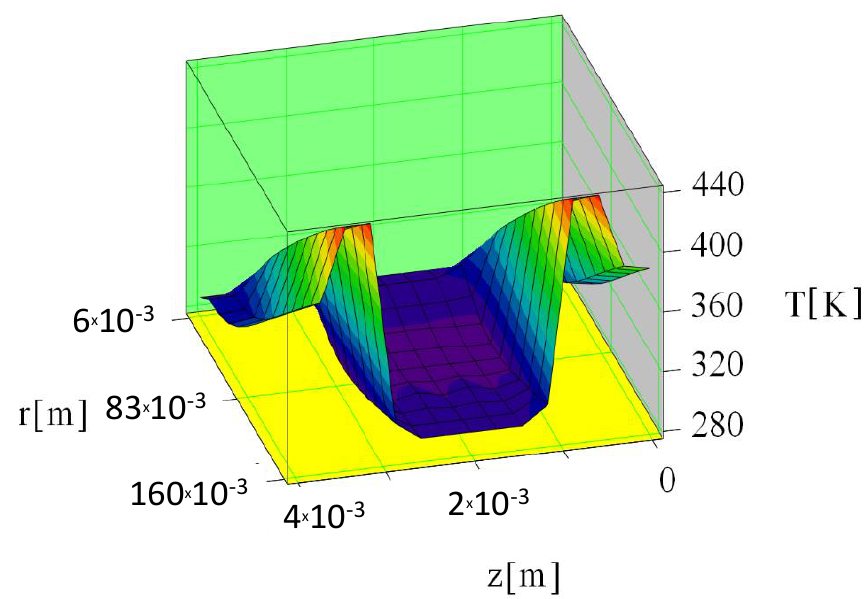
Figure 8. Graph of the temperature distribution within the disk gap with parameters corresponding to Figure 2 ( h = 4 × 10 –3 m).